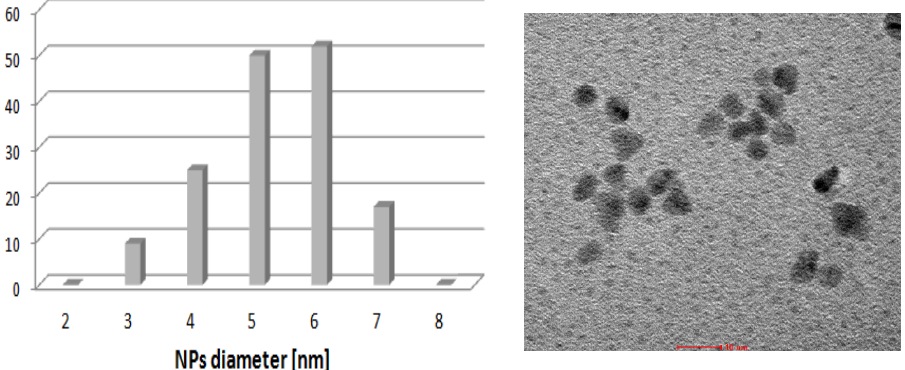
Figure 7. TEM micrograph and nanoparticles size distribution for the sample of